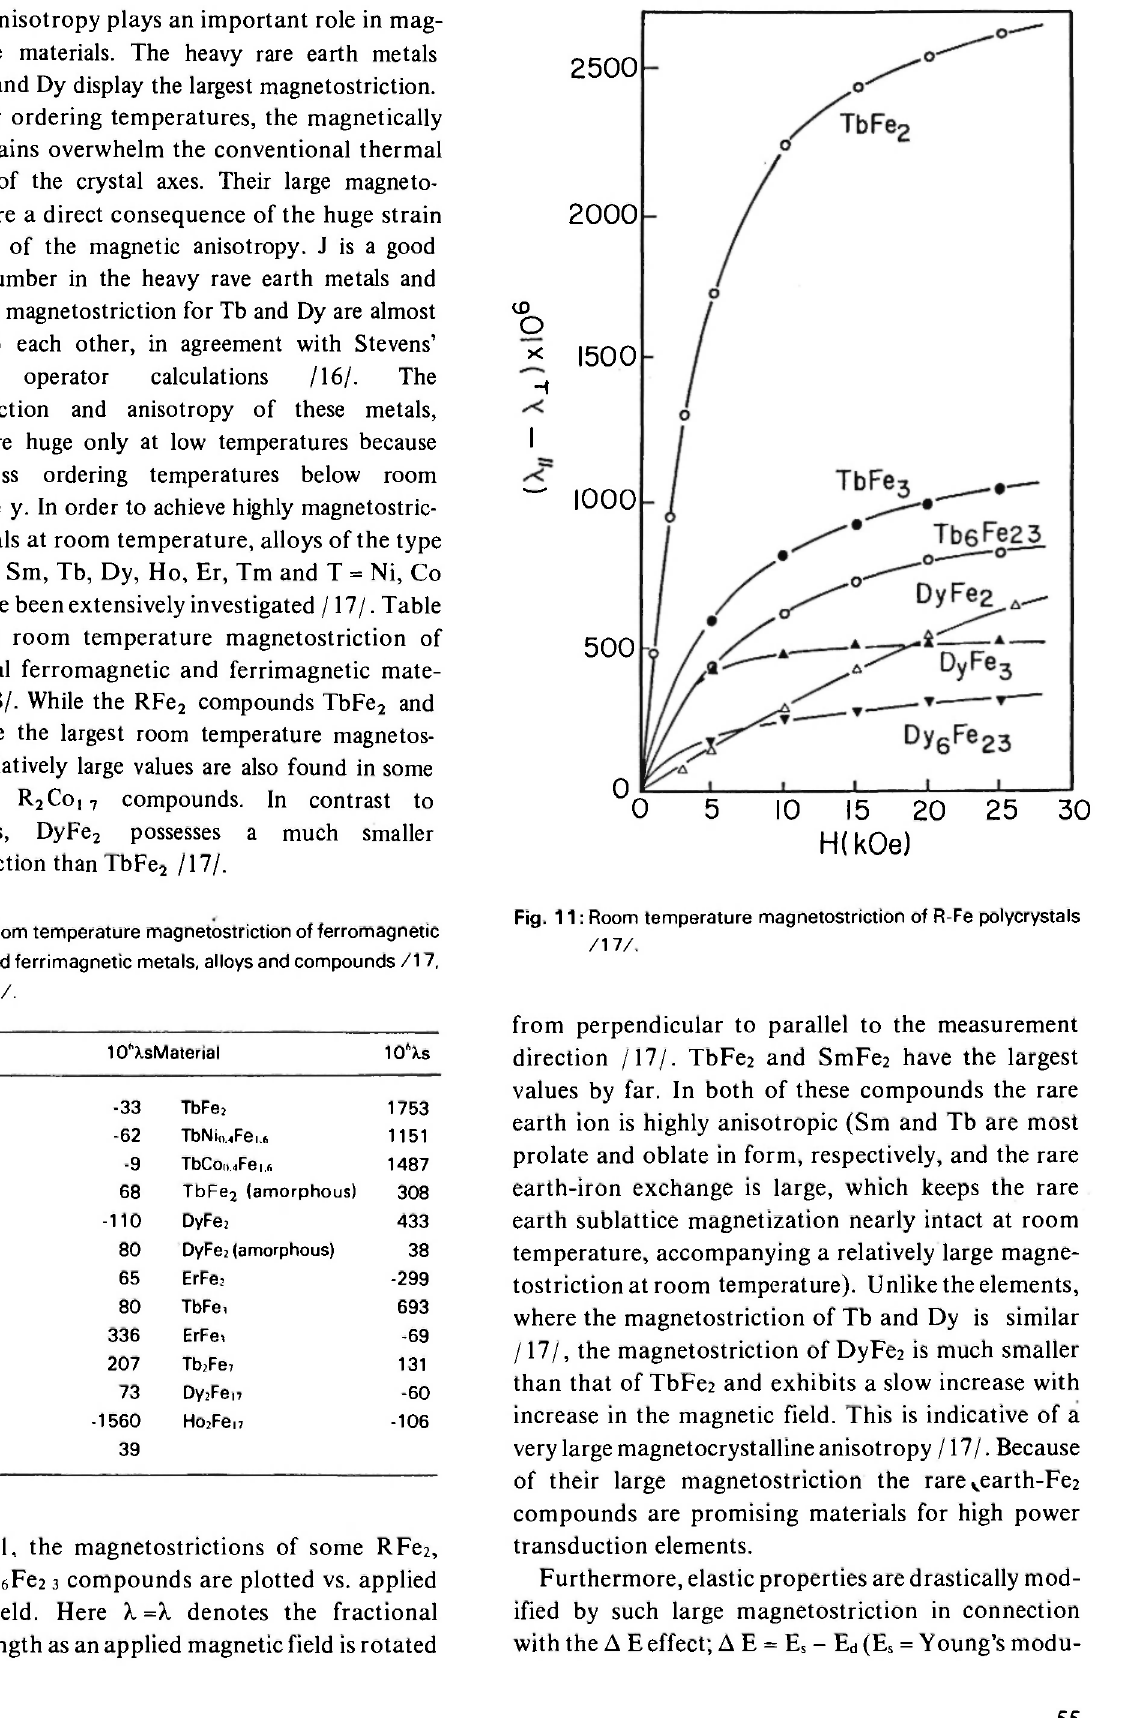
Fig. 11 : Room temperature magnetostriction of R-Fe polycrystals /17/. from perpendicular to parallel to the measurement direction /17/. TbFe2 and SmFe2 have the largest earth ion is highly anisotropic (Sm and Tb are most prolate and oblate in form, respectively, and the